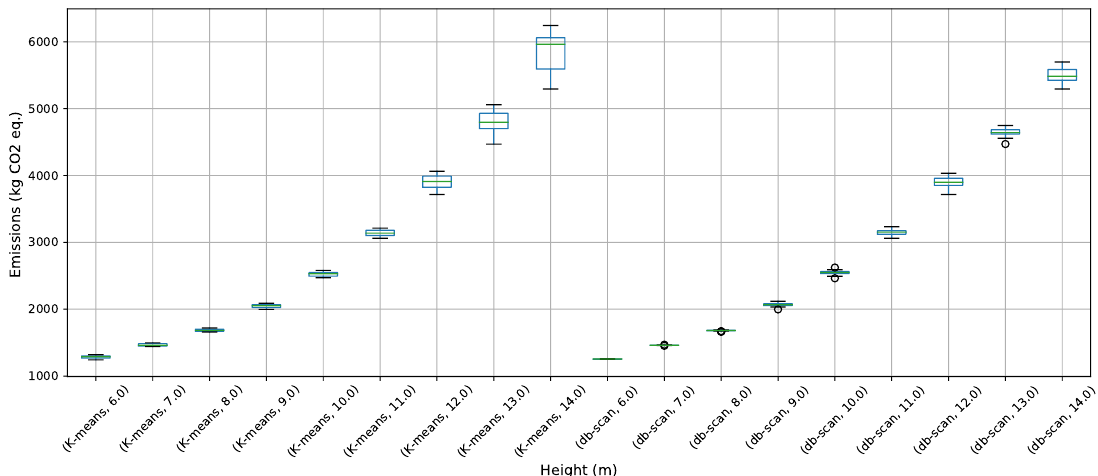
Figure 11. Emission box-plots, comparison between db-scan and k-means operators.